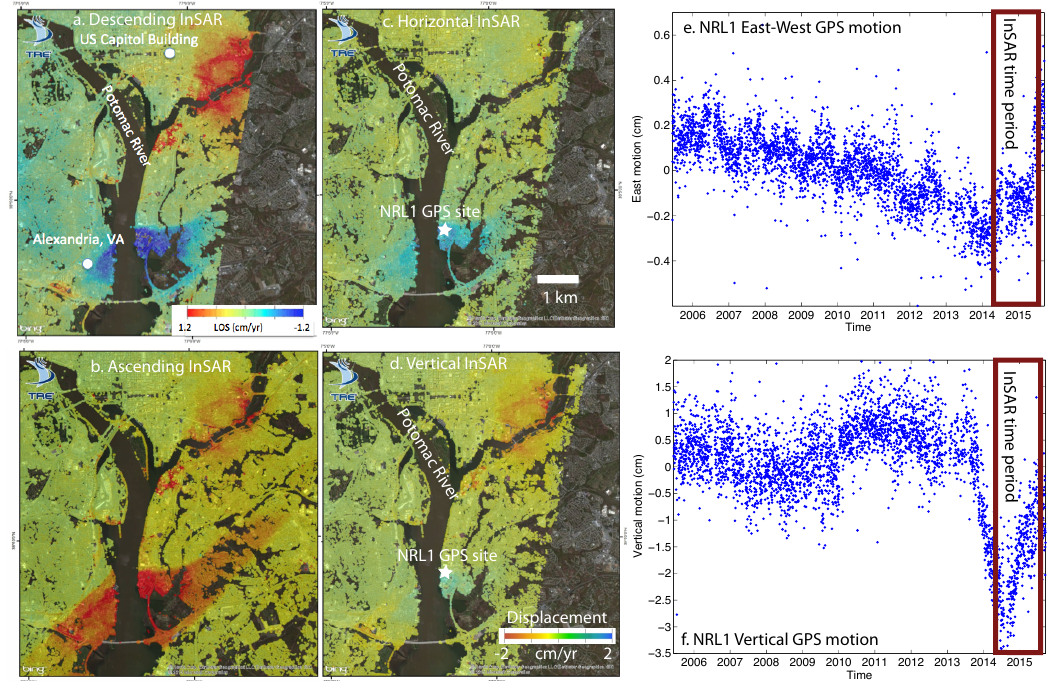
Figure 13. InSAR data near Washington, DC, from CSK and processed by TRE Canada using the SqueeSAR TM technique for a collaborative project with the University of Virginia and the Virginia Department of Transportation funded by the United States Department Of Transportation [33,34]. ( a ) Time series from 28 descending CSK SAR acquisitions spanning from March 2014 to June 2015 where blue indicates movement toward the satellite (e.g., uplift and/or eastward motion). ( b ) Time series from 40 ascending CSK SAR images spanning from February 2013 to August 2015. The average displacement rate standard deviation for all measurement points for the descending dataset (which characterizes the error of the measurements) was calculated to be ± 0.23 cm/yr, and should be smaller for the ascending dataset since it contains more dates. These two tracks were combined to decompose the east–west ( c ) and vertical motion ( d ) in the common time period (March 2014 to June 2015) shown as a red box in ( e , f ). Subsidence is observed in the northeast part of the image, while an unusual combination of mostly east–west ( e ) and some uplift ( f ) is seen near the Naval Research Lab GPS site (NRL1) during the time period when the InSAR deformation was observed. Global positioning system (GPS) displacements are with respect to the NA12 reference frame [61] and were processed by the University of Nevada, Reno (e.g.,